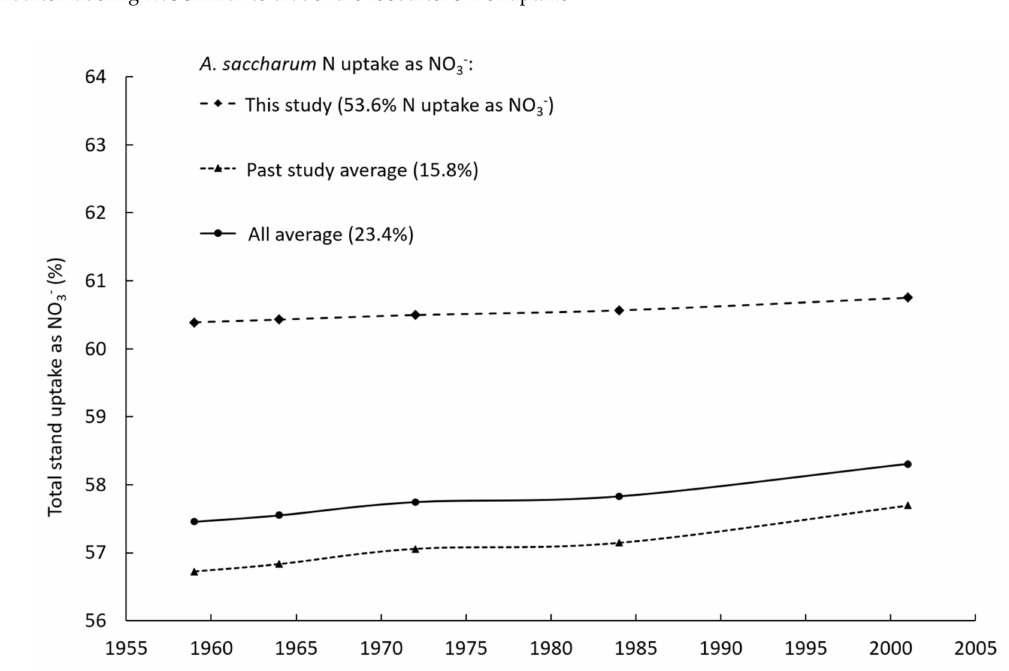
Figure 3. The contribution of NO 3 − to total stand uptake of N from 1959 to 2001. Different lines represent different estimates of uptake of N as NO 3 − for A. saccharum , based on prior studies, this study, and the average of all available